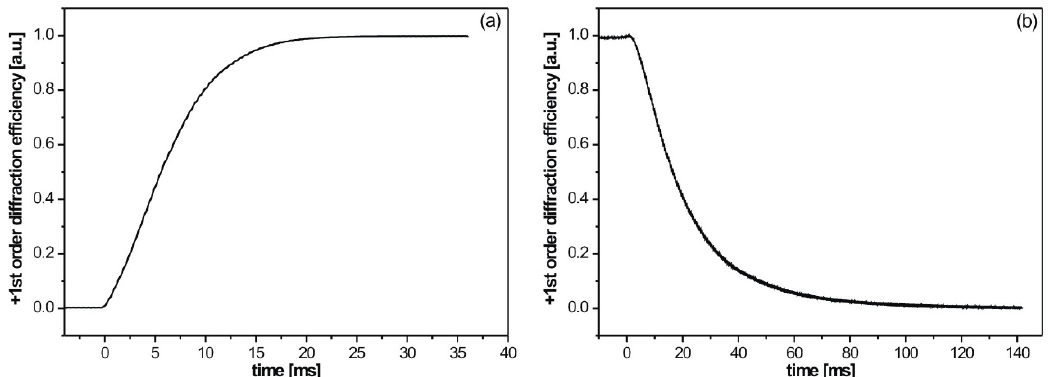
Figure 7. Intensity of the first-order diffracted 690 nm beam by the LC_1 cell as a function of time when changing a driving voltage amplitude from ( a ) 1.35 V to 2.2 V, and ( b ) 2.2 V to 1.35 V, which corresponded to switching the transmitted light between the zeroth and first diffraction orders.